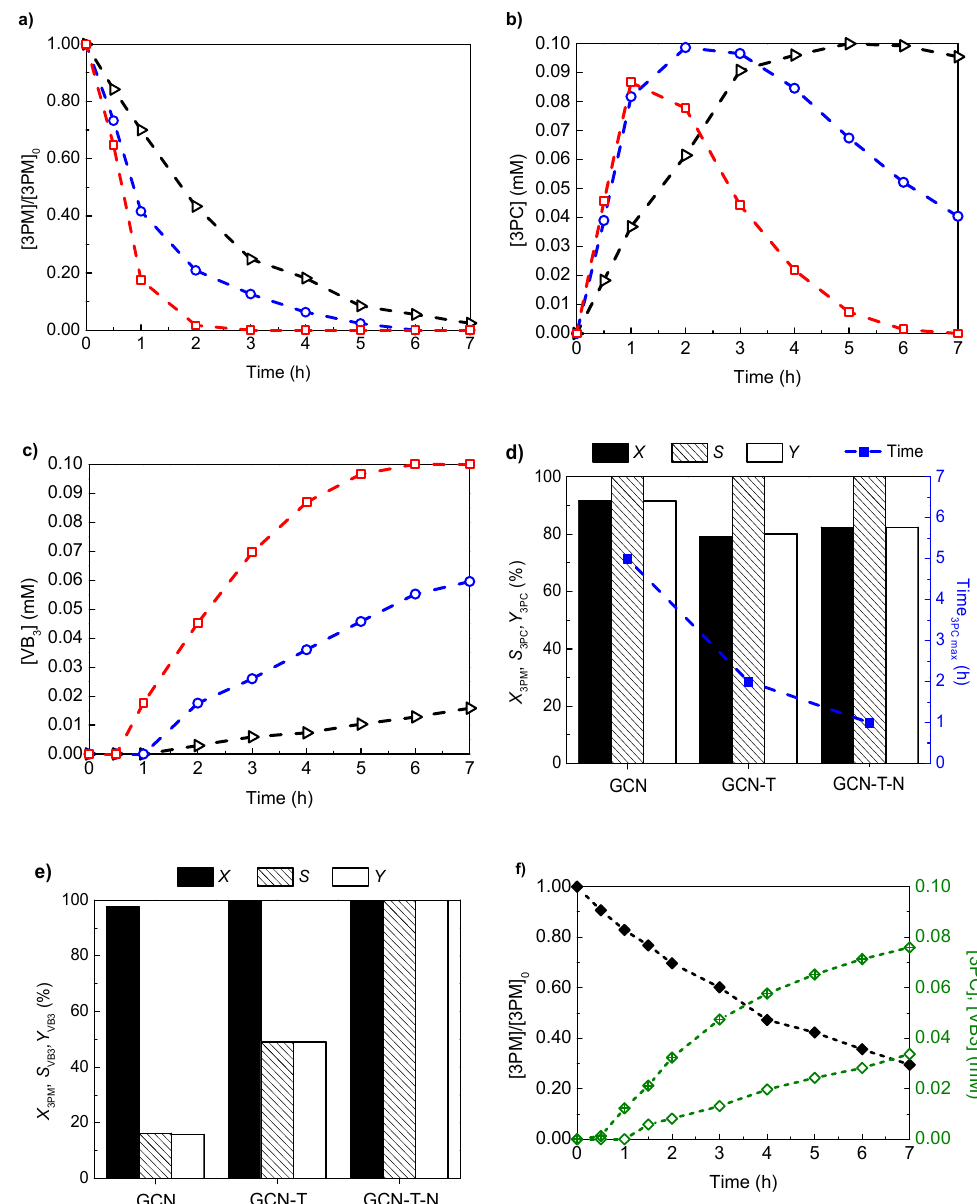
Figure 4. ( a ) Normalized 3PM, ( b ) 3PC, and ( c ) VB3 concentrations over 7 h of irradiation ( λ max = 412 nm) using GCN ( ω ), GCN-T-N ( □ ), and GCN-T ( ○ ) as catalysts. ( d , e ) X , S , and Y obtained for the photooxidation of 3PM into 3PC and VB3 at the maximum of their production, respectively. ( f ) Nor- malized 3PM ( ♦ ), 3PC ( ), and VB3 ( ◊ ) concentrations over 7 h reaction using immobilized GCN- T-N.